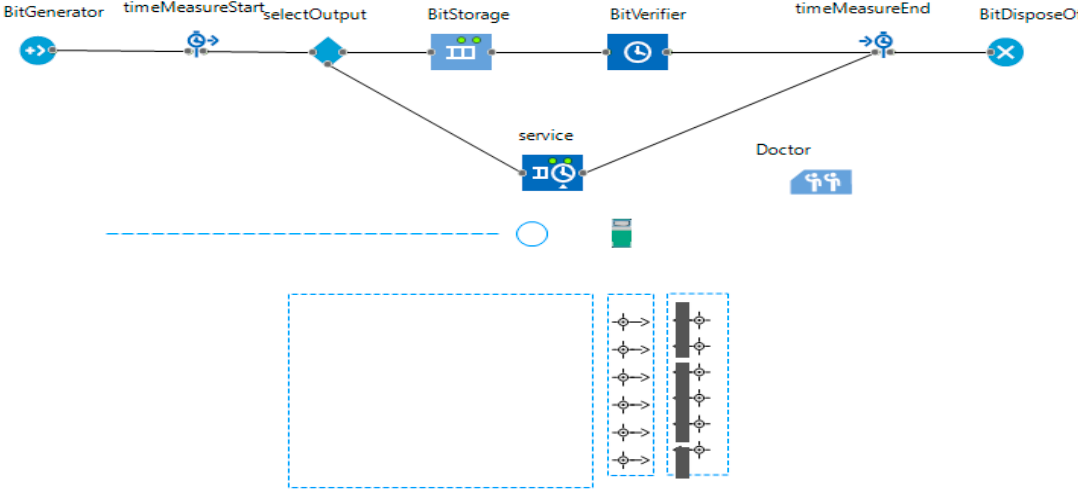
Figure 32. AnyLogicPoG Bit Verifier Circuit for Patient-Doctor Model.